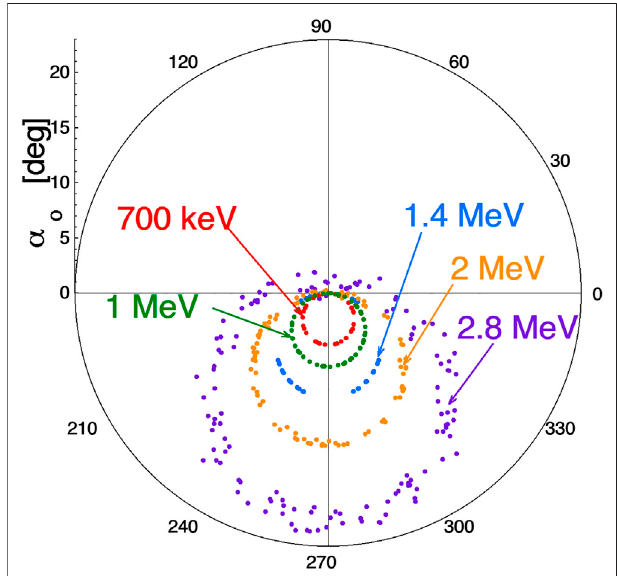
FIGURE 5 | Five protons with fi ve different kinetic energies (colors) are launched from the geosynchronous-orbit equator with α o (cid:1) 0 o and the ( α o , ϕ o ) values of their northward-gong equatorial crossings are plotted as the (1 o , 90 o ) of the 1,000 protons are plotted as the large red point in Figure 4 . Each proton, when it has traveled for exactly a time 2.282 s (halfway in time to its fi rst mirror point), is given a 3 o de fl ection in its velocity vector in a random direction normal to its instantaneous velocity vector, keeping its kinetic energy constant. (This could represent the interaction of the particle with some wave along the particle ’ s orbit, although in a very controlled and idealized way.) The equatorial pitch angles and gyrophase angles of the fi rst northward equatorial crossings of the 1,000 protons that each experienced a single 3 o de fl ection are plotted as the blue points in Figure 4 . The black circle in the fi gure is the circle that unscattered (unperturbed) protons make as they bounce and cross the equatorial plane. As seen in Figure 4 , the aberrated black circle is uniformly broadened by off- equatorial pitch-angle scattering, and the black aberrated circle organizes the behavior (diffusion) of the non-equatorial scattering in equatorial pitch angle and gyrophase angle. Another form of angular scattering is fi eld-line-curvature (FLC) scattering. FLC scattering is parameterized by the “ adiabaticity parameter ” ε (cid:1) r gyro /R c at the equator, where r gyro is the gryroradius of the particle with pitch angle 90 o and R c is the equatorial radius of curvature of the fi eld lines. ε (cid:1) r gyro /R c (cid:1) 3 γ mcv o /eB is related to the loss-cone shift at the equator θ tilt (cid:1) arctan (v curve /v || ) (cid:1) arctan (3 γ mcv o cos ( α o )/eB). At small angles ε ≈ θ α o , tilt . Hence, the strength of FLC scattering is parameterized by the size of the loss-cone tilt (Borovsky et al., 2022). If the ε (cid:1) r gyro /R c value of a particle is larger than 0.1 – 0.2, the particle begins to stochastically scatter each time it crosses the equatorial region of the dipole (e.g. Dragt and Finn, 1976; Birmingham,